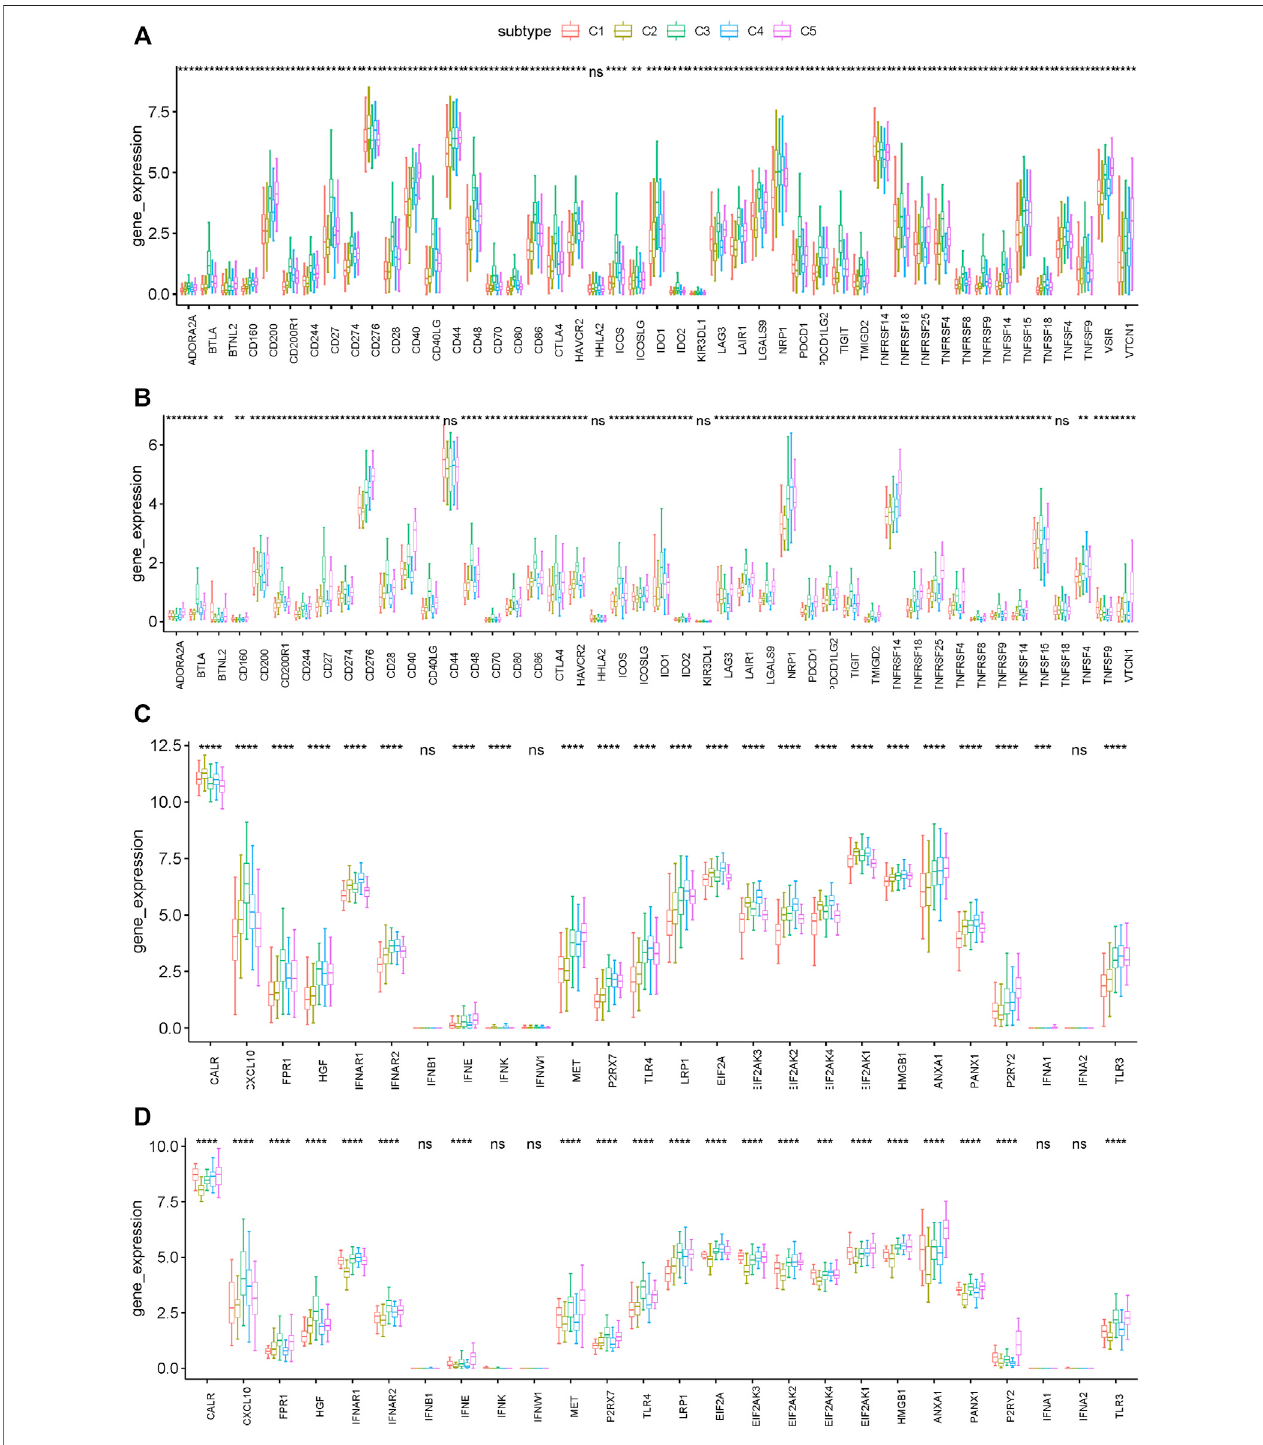
FIGURE 6 | Association between immunesubtypes and ICPs and ICD modulators. (A,B) Differential expression ofICP genes among the PRAD immune subtypes in (A) TCGA and (B) ICGC cohorts. (C,D) Differential expression of ICD modulator genes among the PRAD immune subtypes in (C) TCGA and (D) ICGC cohorts. * p < 0.01, ** p < 0.001, *** p < 0.0001, and **** p < 0.00001.